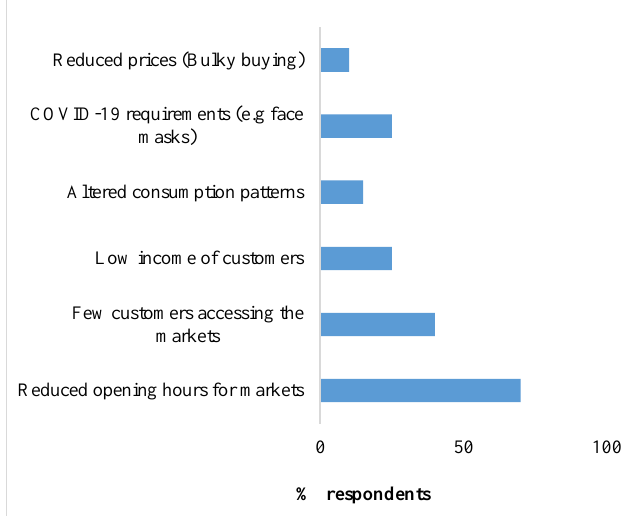
Figure 3. Possible reasons for the reduced sales of horticultural produce during the lockdown, values in percentage